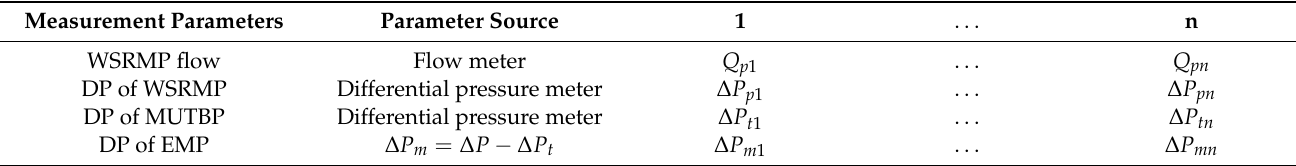
Figure 4. Measurement control system. In this process, three parameters are fed into the control module, namely the impedance of equivalent main pipe ( S m ), obtained during the initial preparation stage, the real-time fl ow rate ( Q p ′ ), and the real-time di ff erential pressure ( Δ P p ′ ), measured, respectively, by the fl ow sensor and the pressure sensor during the control stage. The control module generates the corresponding inverter command in accordance with the control logic to guide the pump inverter. Table 2. Measured value during preparation.